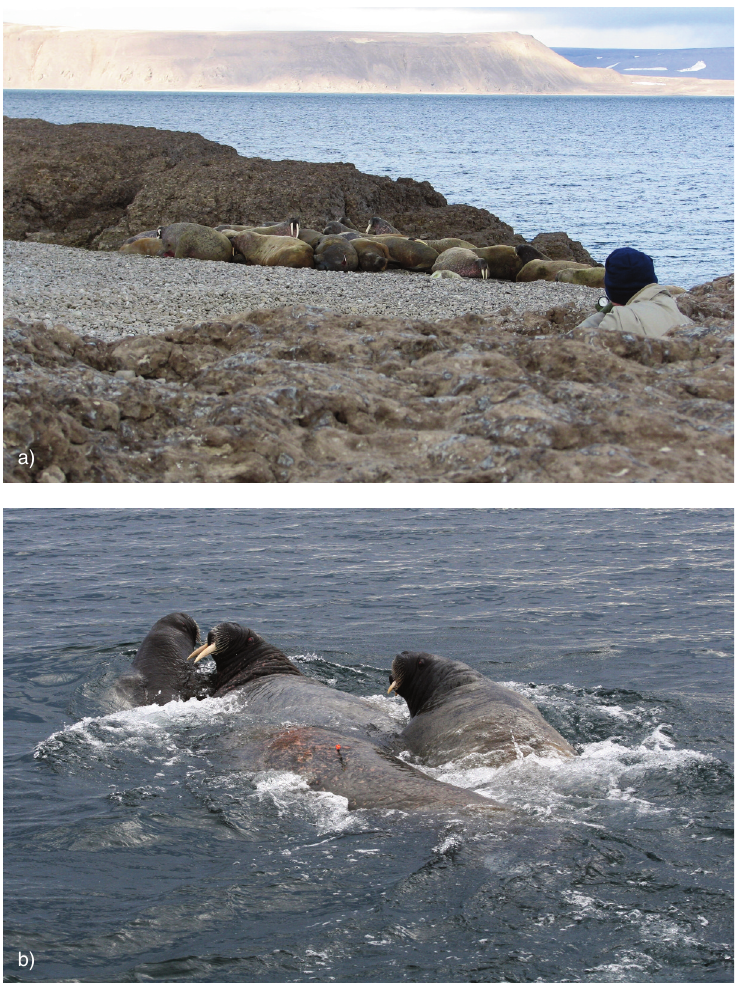
Fig. 3. Biopsies were taken using a CO 2 powered dart gun (a) usually on land but also (b) in the water in Hoare Bay (photos by A. MacHutchon